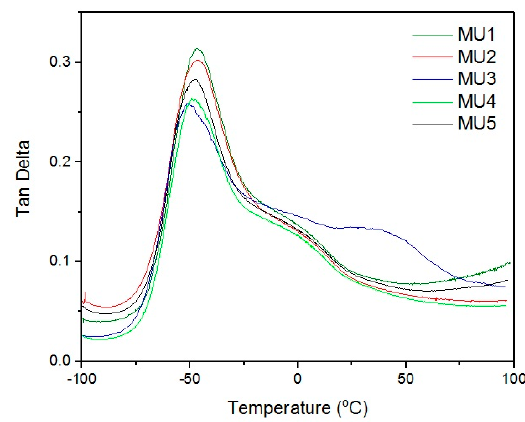
Figure 9. Relations between phase angle and temperature.